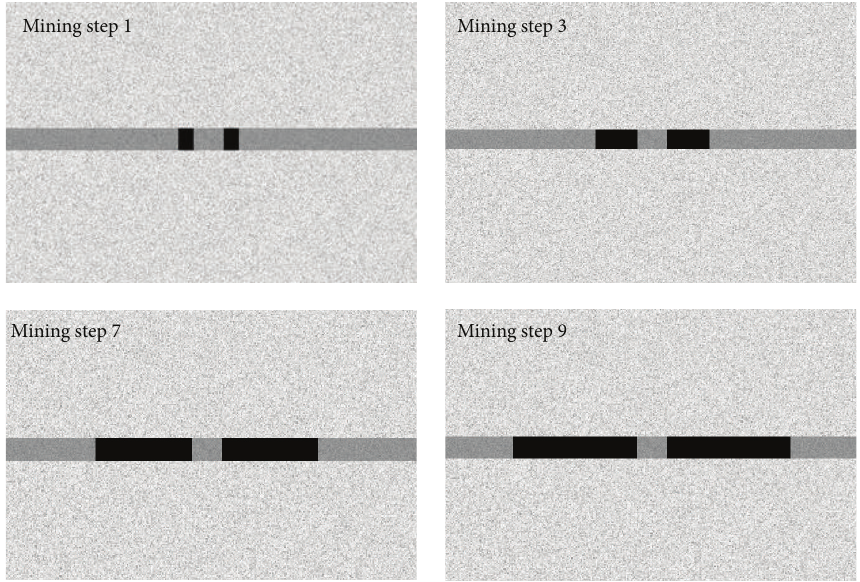
Figure 3: Mining sequence and pillar geometry within the RFPA2D